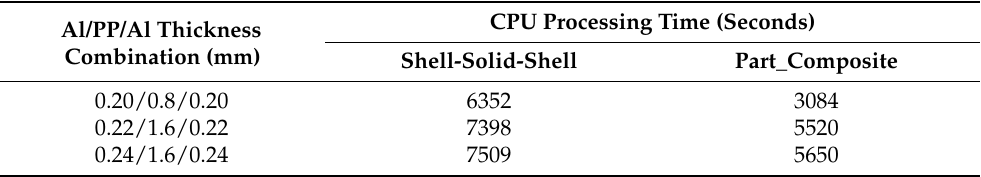
Table 9. CPU processing time for three sandwich thickness combinations with two different modelling approaches.